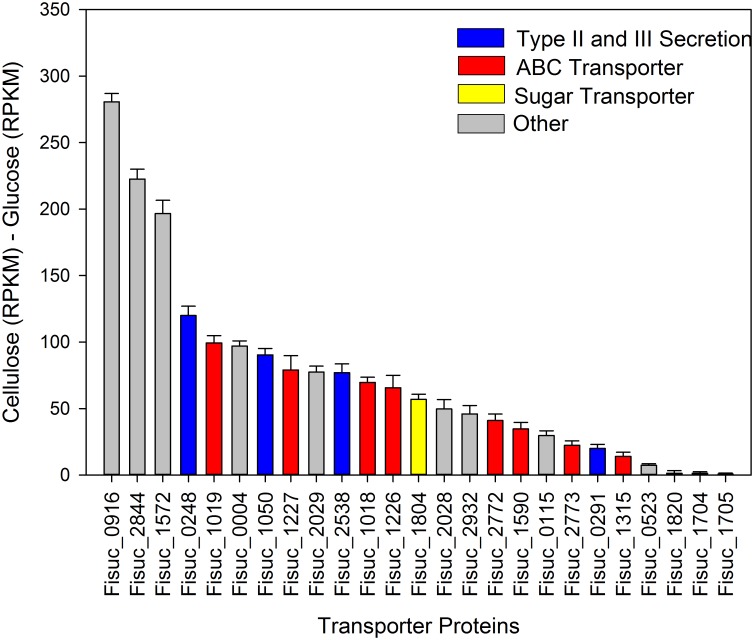
Difference in expression between cellulose and glucose cultures for transporters, secretion systems, effluxes, and exporters genes.All type II and III secretion systems had higher expression in the cellulose cultures than the glucose cultures suggesting they may have a role in secreting the carbohydrate active enzymes into the extracellular medium. RPKM = Reads Per Kilobase per Million mapped reads.